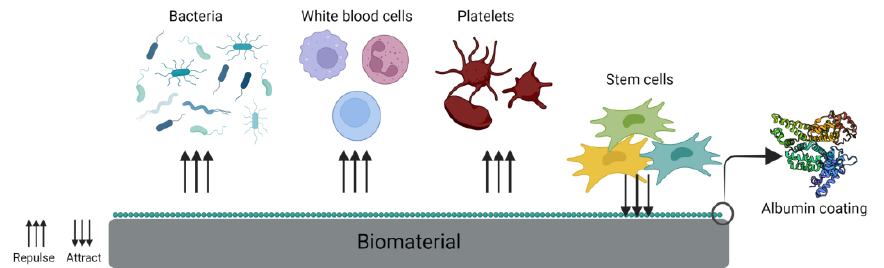
Figure 3. Albumin coating on a biomaterial surface. Created with BioRender.com accessed on 21 August 2022.